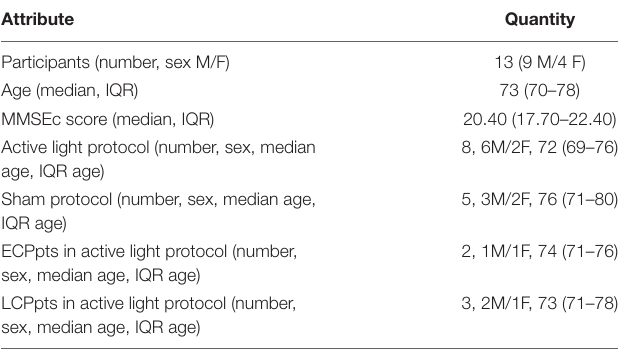
TABLE 1 | Demographic and clinical features of